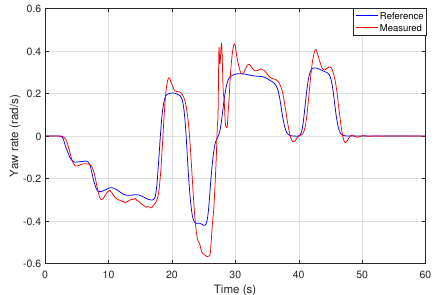
Figure 16. Yaw-rate tracking during